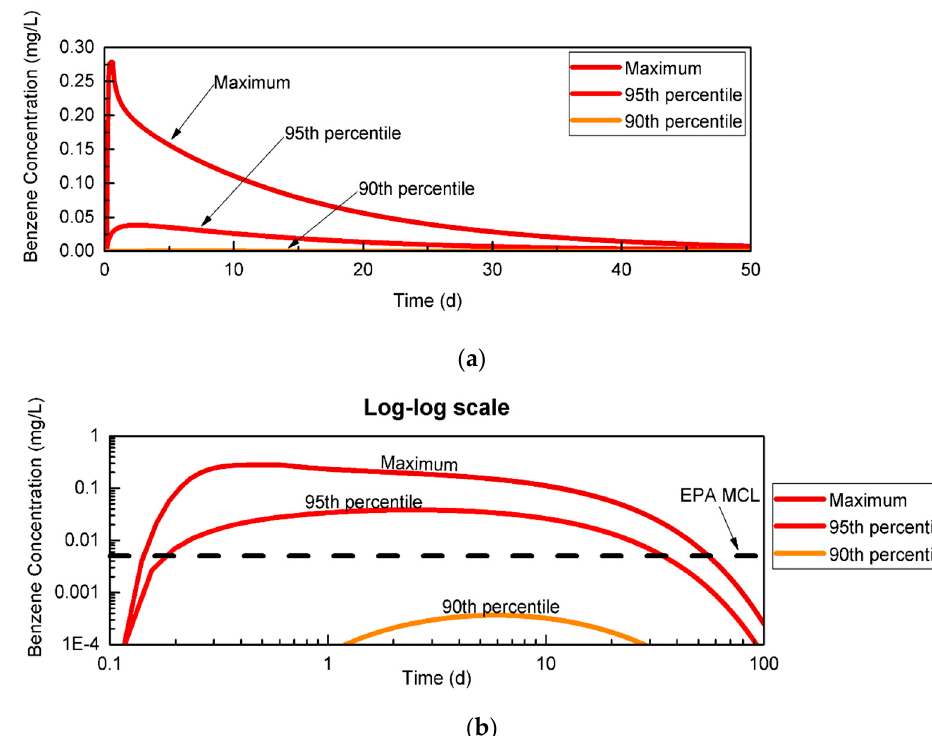
Figure 5. Benzene concentration breakthrough curves predicted at a 2 ft groundwater table, ac- counting for degradation and sorption on a ( a ) linear scale; ( b ) log–log